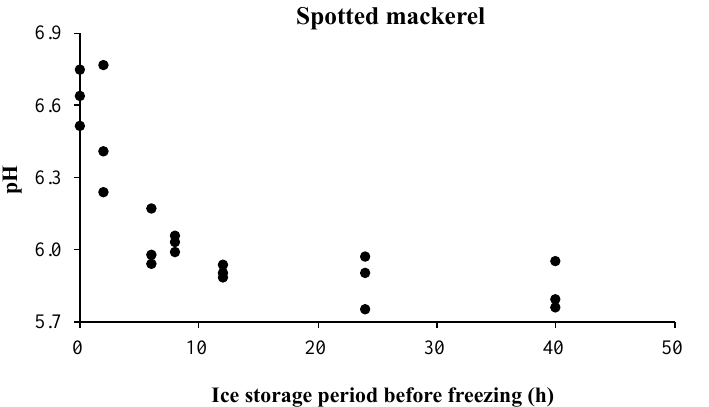
Figure 3. Changes in pH of frozen spotted mackerel fillets previously stored for different ice-storage periods.